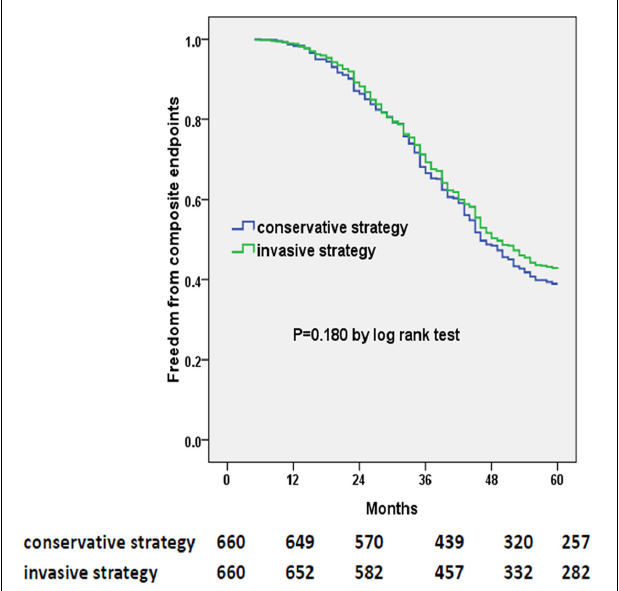
FIGURE 2 | Kaplan–Meier curves of freedom from composite endpoints. The numbers at the bottom of the figure are “number at risk.”